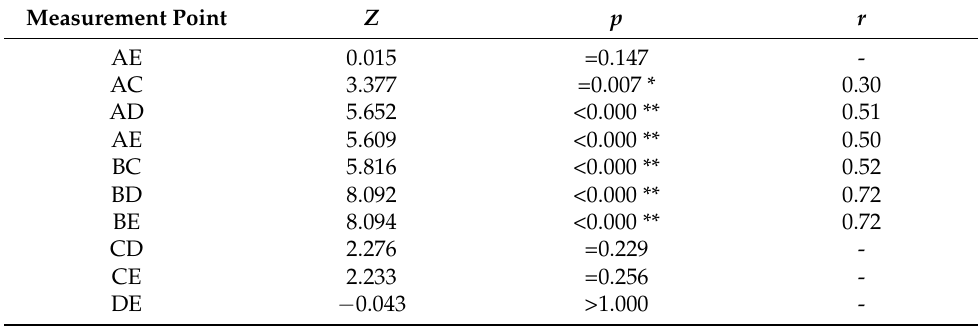
Table A3. Ceramic 3y_HF ( χ 2 (4) = 102.02; p < 0.000); N = 125.